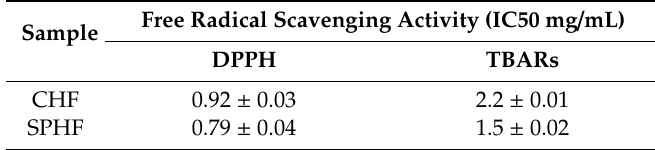
Table 2. Free radical scavenging activities of CHF and SPHF obtained from Hizikia fusiforme